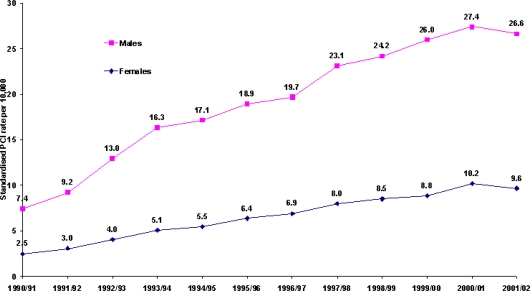
Age standardised PCI rates by gender, 1990–91 to 2001–02 (PCI rates for patients aged 30 years and above per 10,000, using the NSW resident population in December 1990 as the standard).